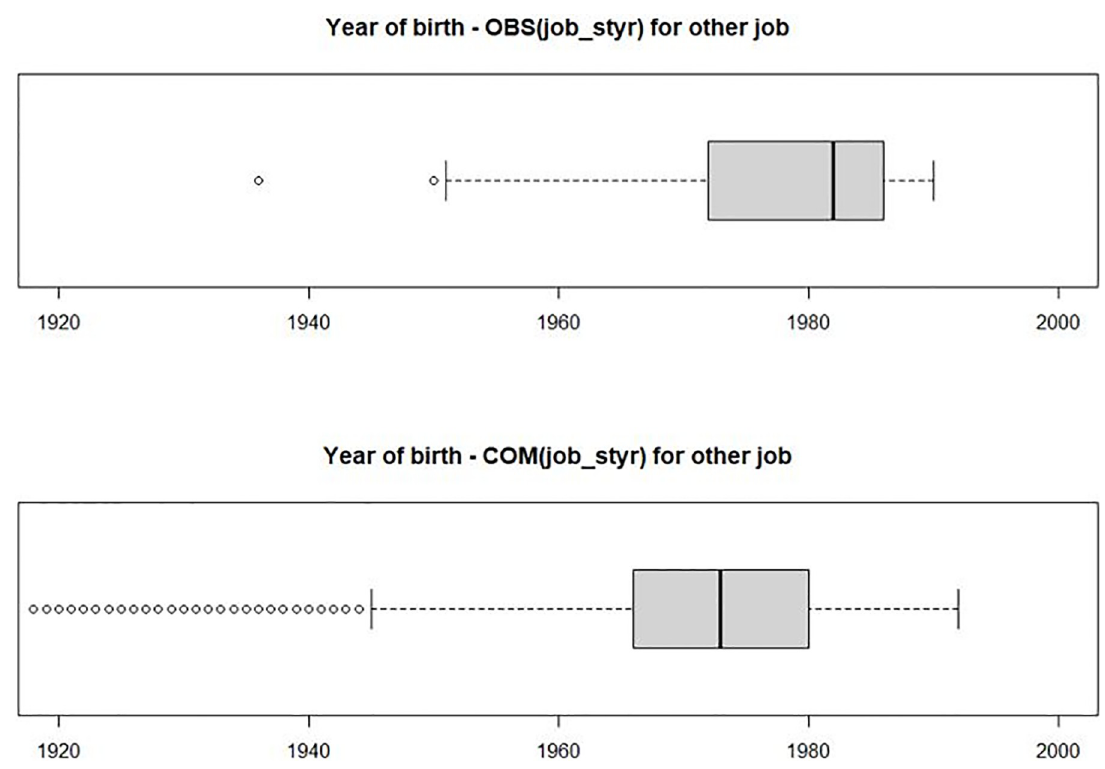
Fig 2. Box plot of year of birth by observed and completed group for starting year of work (other job). Note: OBS: observed data, COM: complete data which combines observed and imputed datasets.